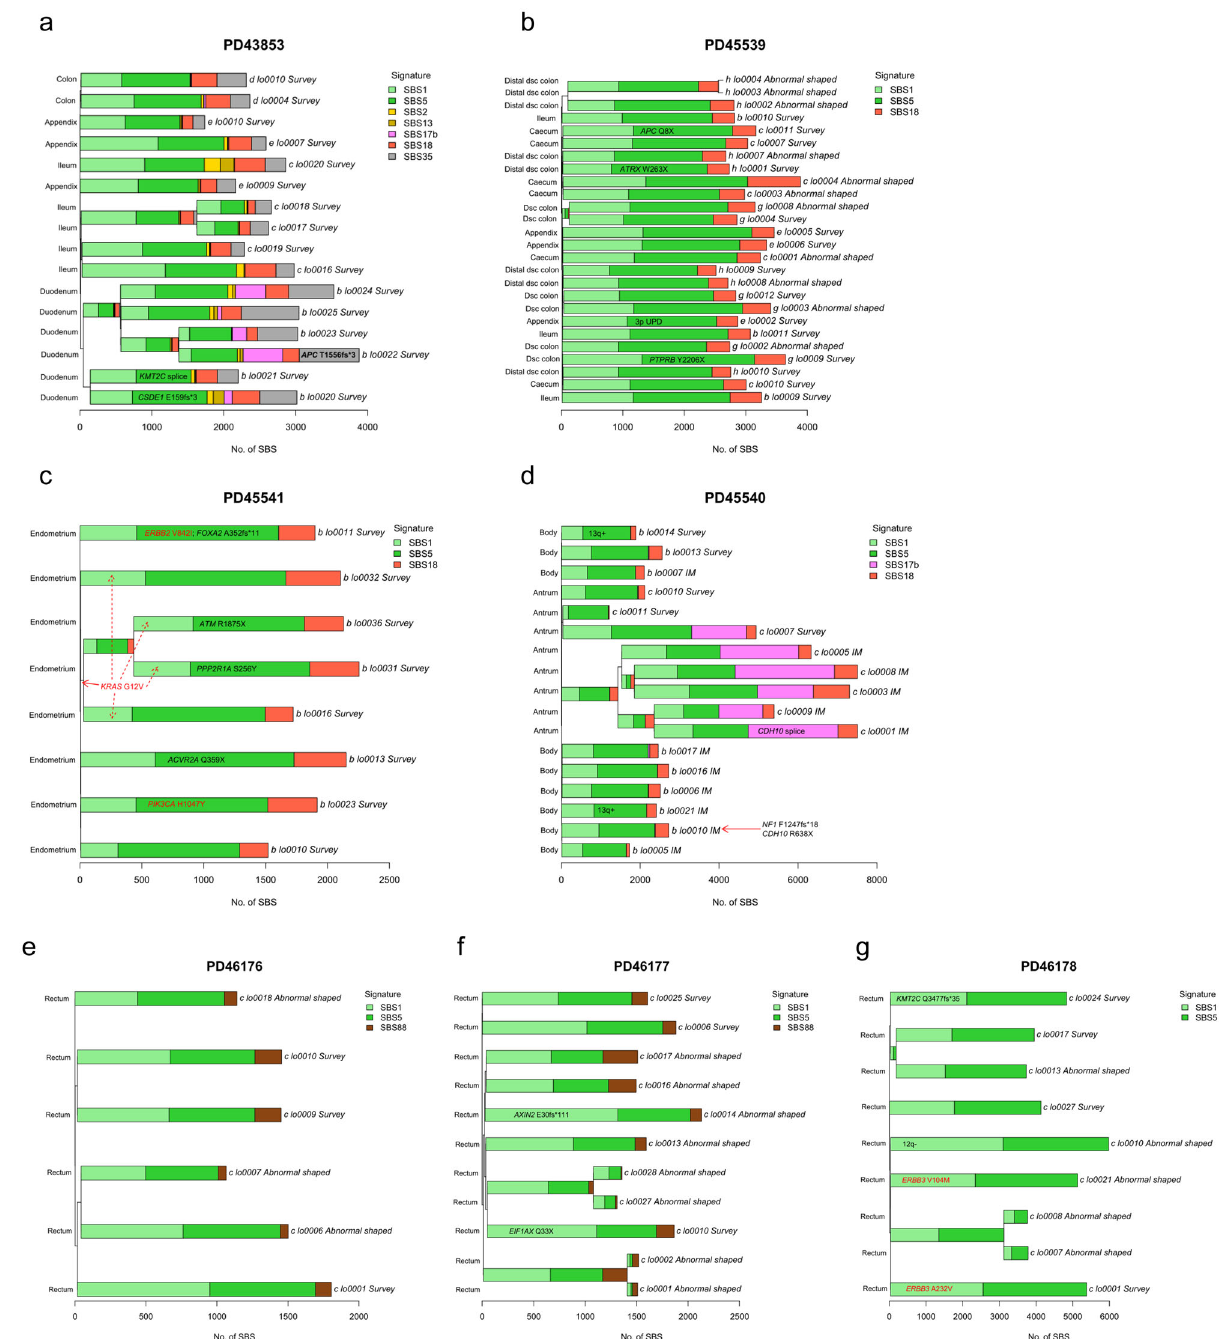
Fig. 3 SBS mutational signatures in the normal epithelium in LS patients. Phylogenetic trees showing the clonal relationship between non-neoplastic crypts in 7 patients ( a , b , e , f , g intestinal; c endometrial; d gastric). Branch lengths correspond to the number of SBS mutations. SBS mutational signatures are mapped onto tree branches. Each crypt is annotated with its identi fi er, crypt type, and tissue origin. Cancer driver mutations and copy number variants are labelled on the corresponding tree branch. Frameshift mutations at microsatellite regions (repeat length ≥ 5) are indicated in bold. Activating mutations of oncogenes are indicated in red. Inactivating mutations of tumour suppressors are indicated in black. c KRAS G12V was an early event and thus annotated on the common branch (red arrow) of the 4 crypts harbouring this mutation (dotted red